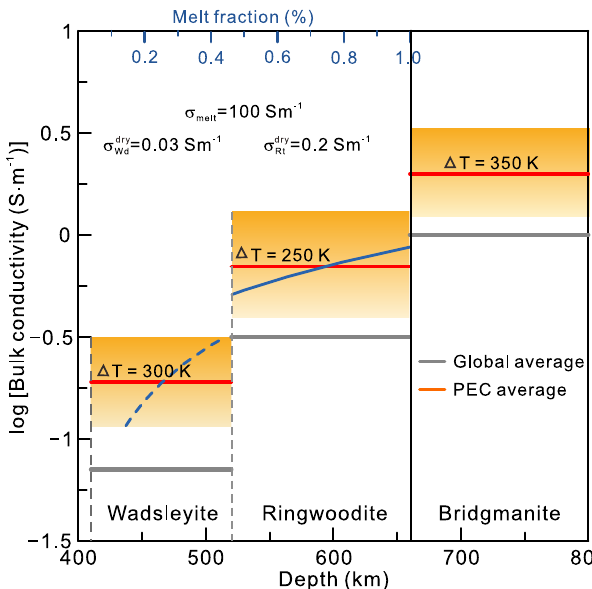
Fig. 3 | Electrical conductivity of the PEC and interpretations of rock proper- ties. The conductivity of the Perm electrical conductivity anomaly (PEC) is indi- cated by the orange zones, with the thick red line denoting the average conductivity. The thick grey line denotes the global average conductivity model 27 , which can be experimentally explained by wadsleyite and ringwoodite containing 0.45 and 0.35 wt.% water, respectively, in the mantle transition zone (MTZ) under normal geothermal conditions ( Δ T=0K). The PEC in the upper and lower MTZ suggestsexcesstemperaturesof300and250K,respectively 30 ,whilethePECinthe lower mantle can be interpreted to possess an excess temperature of 350K 22 . Dashed and solid blue lines are the melting fractions of wadsleyite (Wd) and ring- woodite (Rt), respectively, based on the two-phase Hashin – Shtrikman upper – bound mixing model 64 and estimated from the MTZ bulk conductivity. The conductivity values of dry wadsleyite and ringwoodite 30 , and hydrous silicate melts 50 are provided on the fi rst-order approximation to estimate the melt fraction in the PEC,